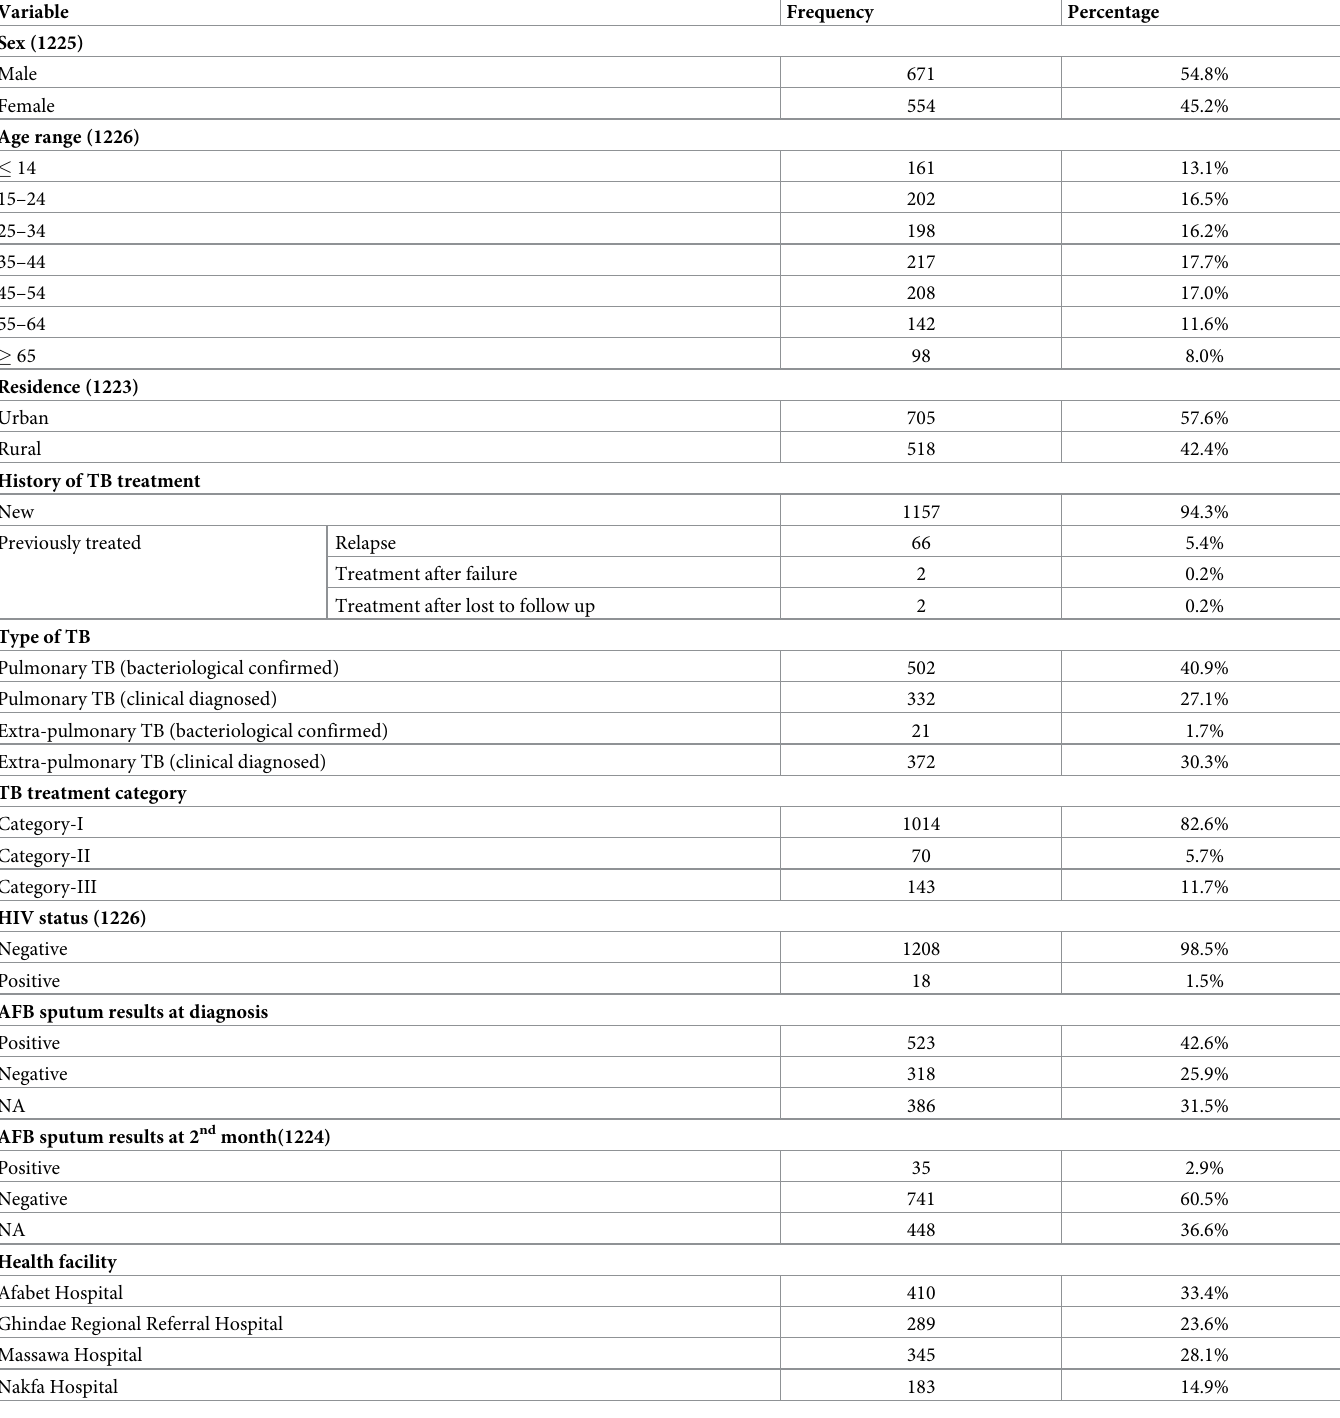
Table 1. Socio-demographic and clinical variables of study participants in Northern Red Sea region, 2014–2019 cohort (n =